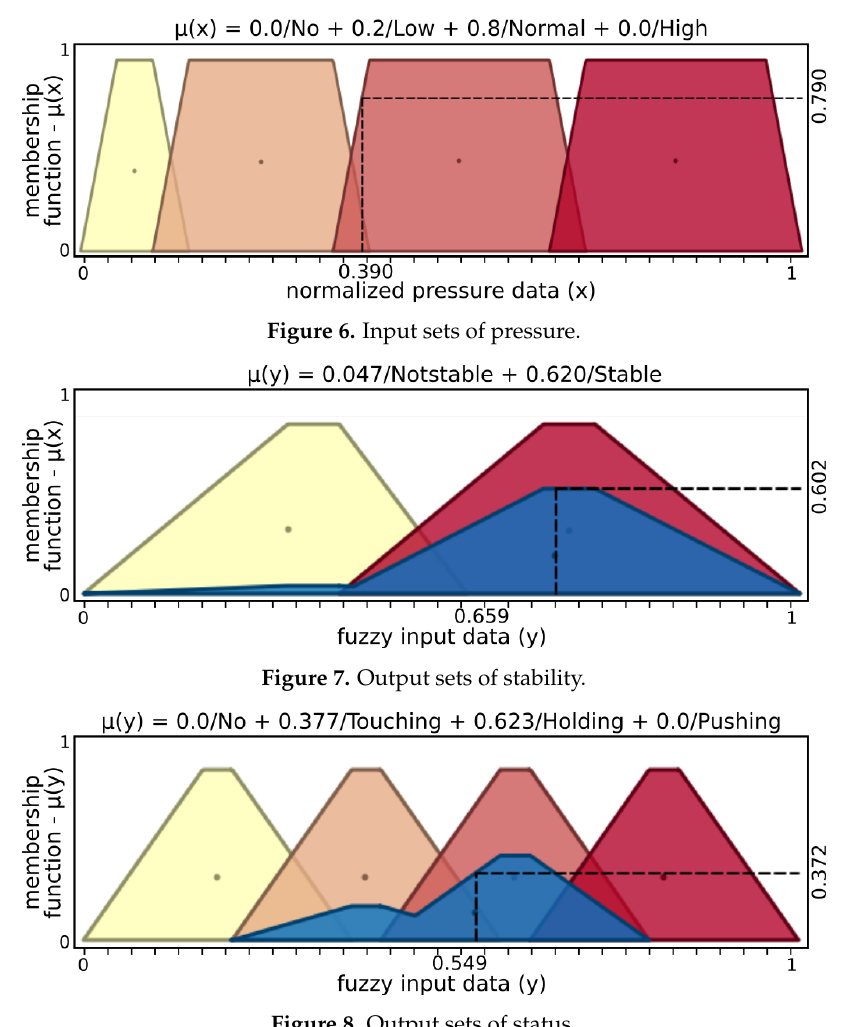
Figure 8. Output sets of status.